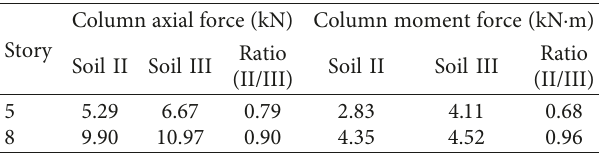
Table 14: Average of maximum column force under far-field